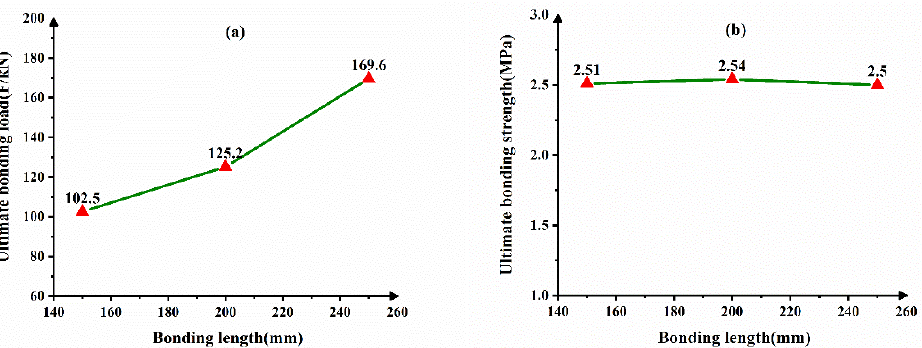
Figure 10. Dependence of bonding length on the interface bonding behavior ( a ) ultimate bonding load ( b ) ultimate bonding strength.